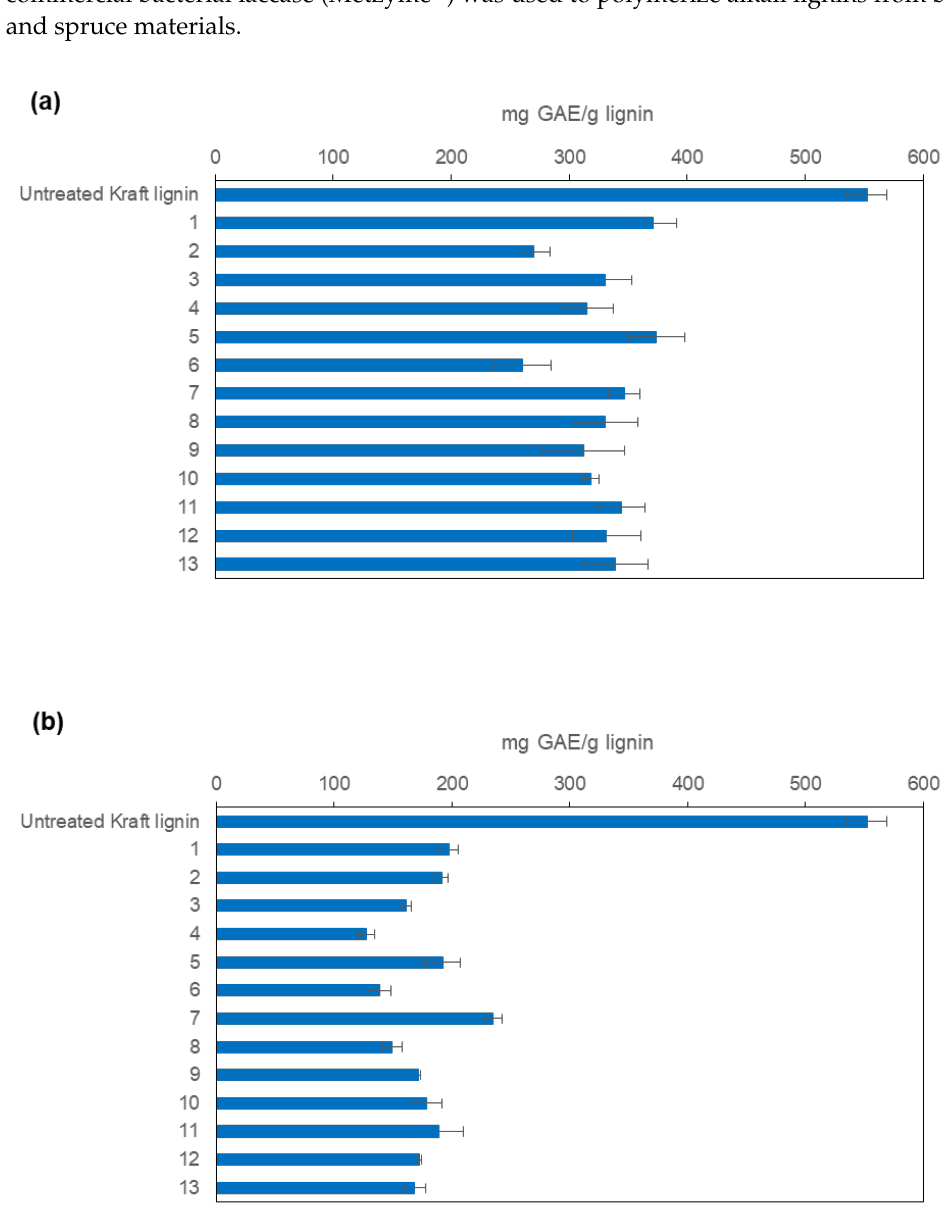
Figure 1. Total phenolic content of the resulting treated lignins with MtL ( a ) and SiLA ( b ) laccases expressed as mg GAE/g lignin (experiments resulting from CCD).